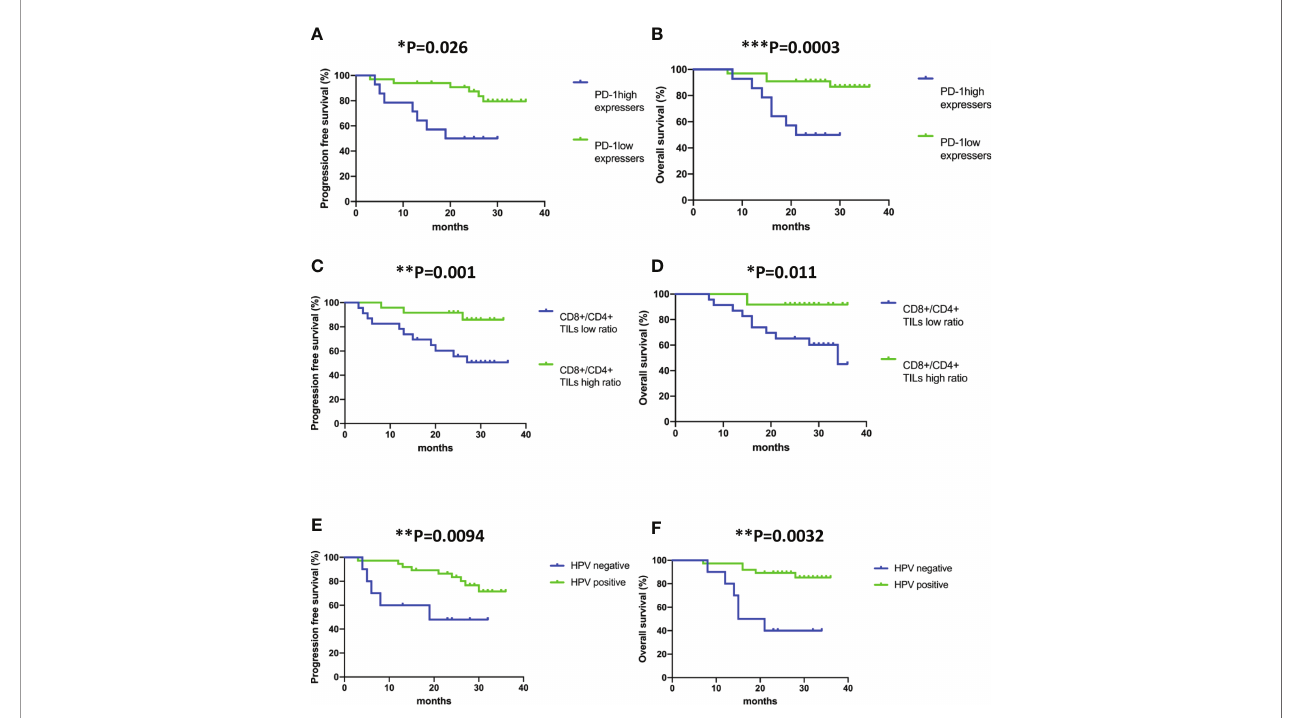
FIGURE 2 | Kaplan – Meier analysis of PD-1 expression status on CD8+ TILs, CD8+/CD4+ ratio and human papillomavirus (HPV) status in all the cases included in the study. (A, C, E) Progression-free survival (time from diagnosis to the fi rst local recurrence or metastasis); (B, D, F) Overall survival (time from the date of diagnosis to the date of death). Deaths without documented progression were censored at the date of death. Survival curves were compared using the log-rank test.